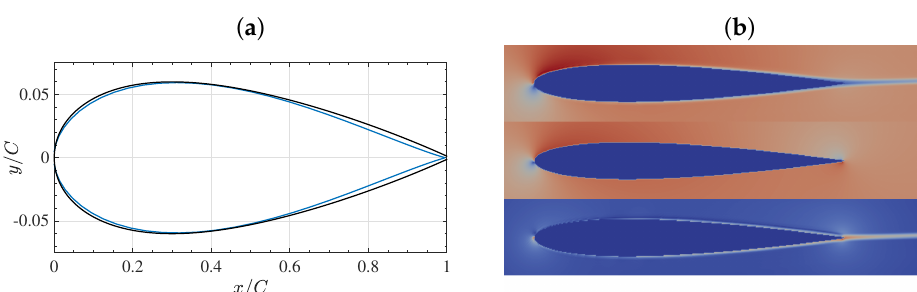
Figure 8. ( a ) Comparison of the Kármán-Trefftz foil profile (—), used to compute the potential (invis- cid) flow component of the flow around the NACA-0012 foil profile (—-) in the pLBM. ( b ) Module of flow velocity calculated with the pLBM at steady state, for ∆ x / C = 2.5 × 10 − 3 and θ = 4 ◦ : (top) total + u P velocity, u i = u I ; (middle) inviscid velocity, u I ; and (bottom) perturbation velocity, u P i i i